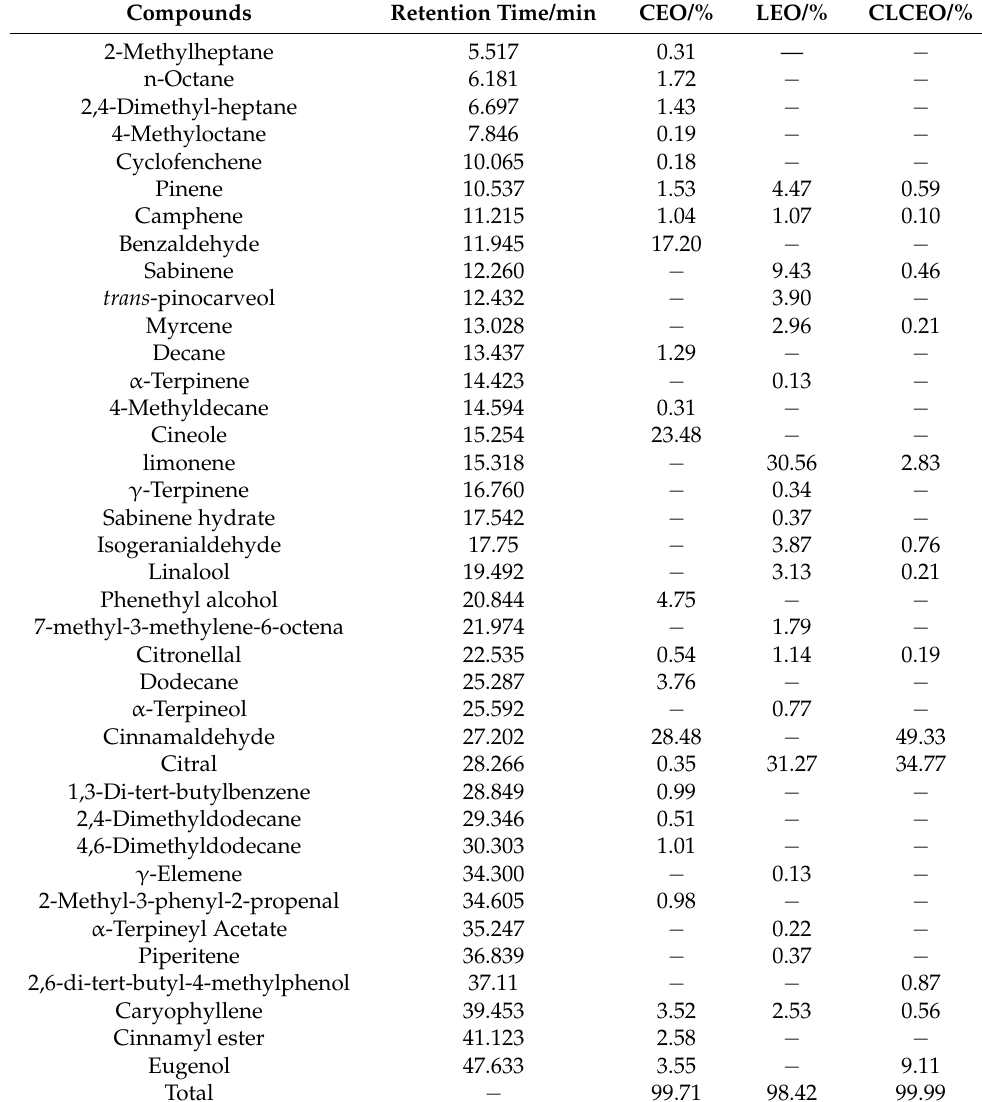
Table 2. Chemical compounds of individual and combined essential